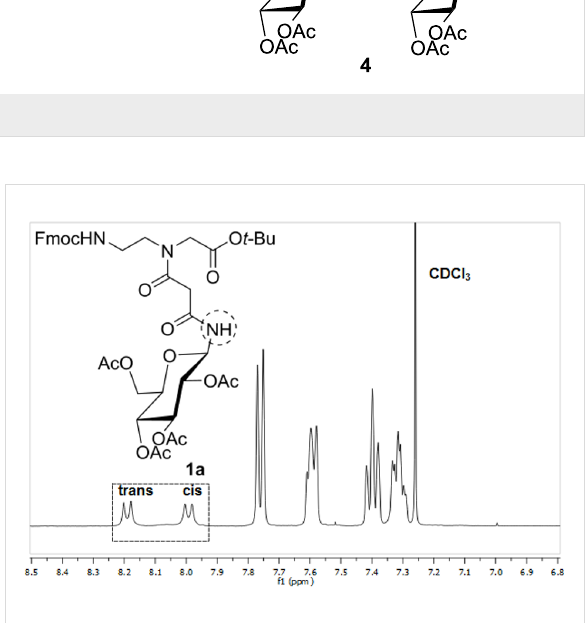
Figure 4: 1 H NMR (400 MHz) of building block 1a in CDCl 3 . The amide signals of the rotamers are marked.